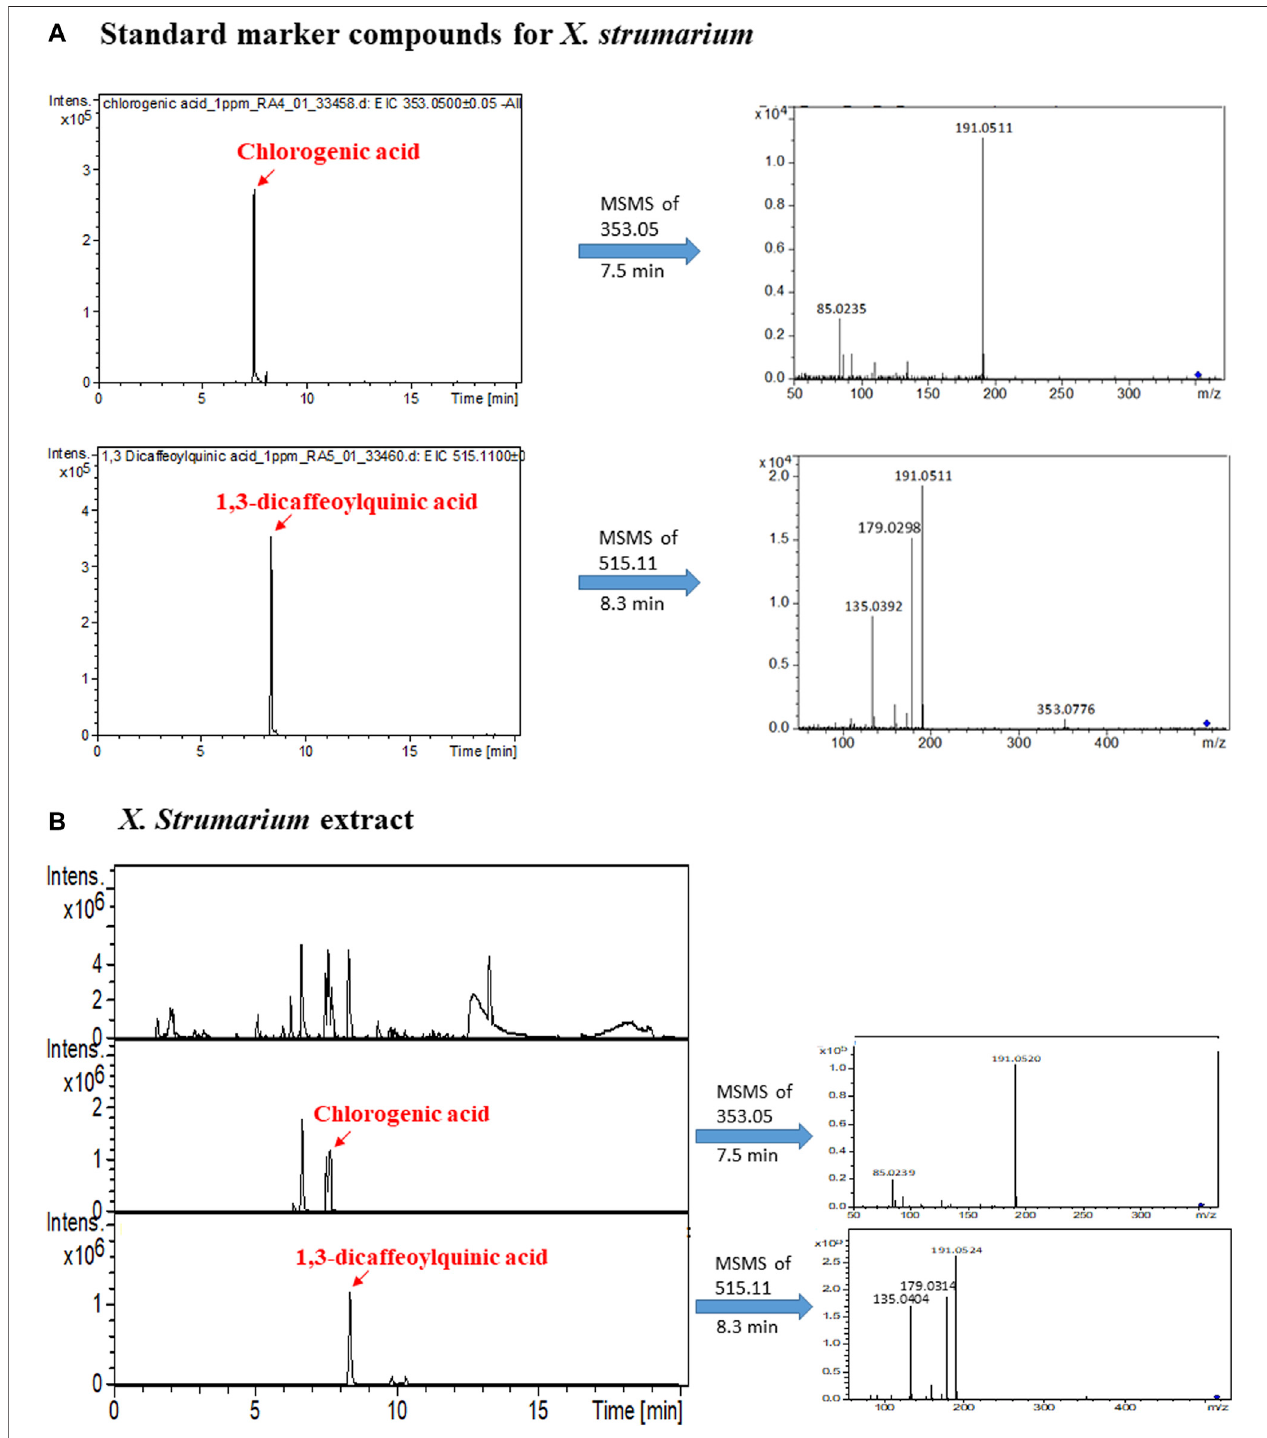
FIGURE 1 | LC-MS/MS analysis of marker compounds and the extracts of X. strumarium and P. montana . (A) Extracted ion chromatogram (EIC) of standards of chlorogenicacidand1,3-dicaffeoylquinicacidand theirfragmentedions. (B) basepeakchromatogram(BPC) andEICofthe X.strumarium extract. (C) EICofstandards of daidzein, genistein, and ononin and their fragmented ions. (D) BPC and EIC of the P. montana extract.